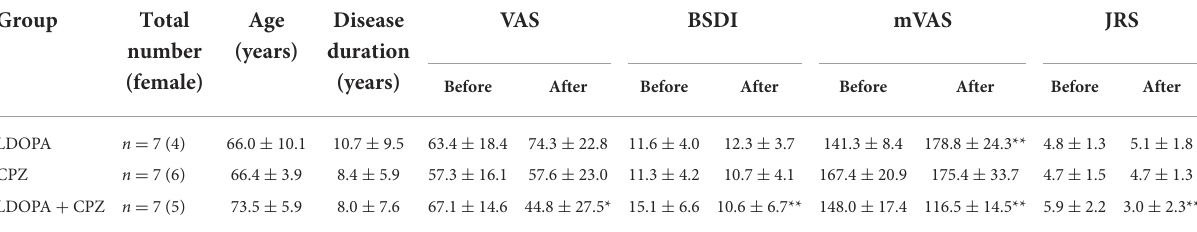
TABLE 1 Assessments of blepharospasm symptoms by VAS, BSDI, mVAS and JRS. Group Total Disease number Before After Before After Before After Before